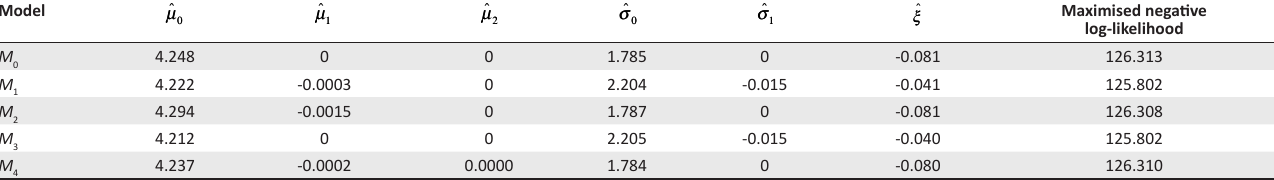
TABLE 1: Annual daily maximum time-dependent generalised extreme value models for Chokwe for the period 1951–2010. Model